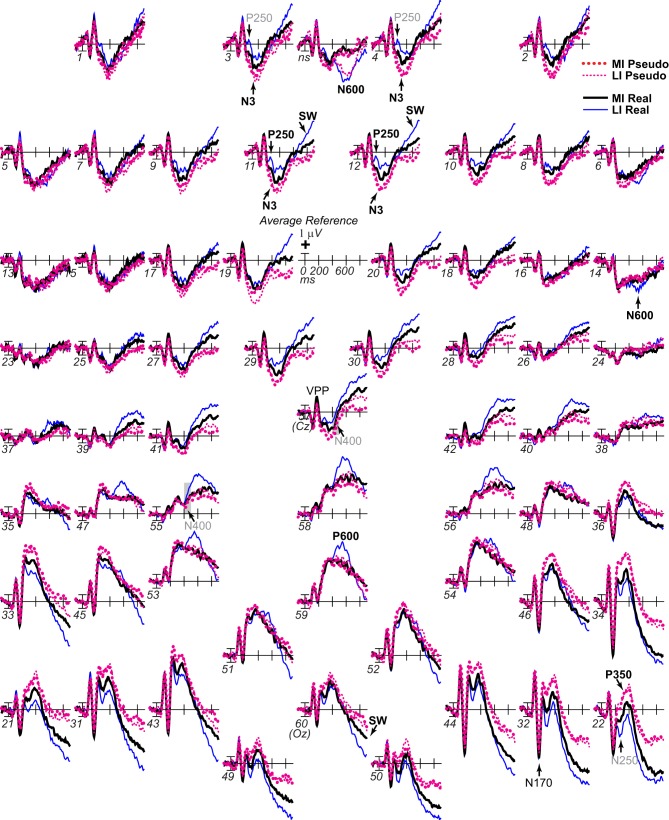
ERP effects of impoverishment and object type with common average reference. As in Figure 3, grand average ERPs are plotted at all sites, but, in order to compare with other work, the reference was computed using the average of all scalp sites (i.e., the “average reference”), and ERPs were instead plotted positive up. ERP effects of impoverishment (more [MI], less [LI] impoverished) and object type (real, pseudo) are shown. Compared with Figure 3, with the average reference, here, the parietal P600 inverts polarity over lateral frontal and frontopolar sites to an N600, especially at the right. The late SW from 500 to 900 ms has an occipital distribution that inverts polarity over frontocentral sites near the midline, and is larger over the left hemisphere. Note, with the common average reference, the N400 pattern (gray shadow) cannot be discerned from the overlapping N3 and P600 times, highlighting the importance of using the same reference sites across studies to identify components and draw conclusions; studies analyzing data using the common average reference may misattribute N3 and/or P600 effects to the N400.